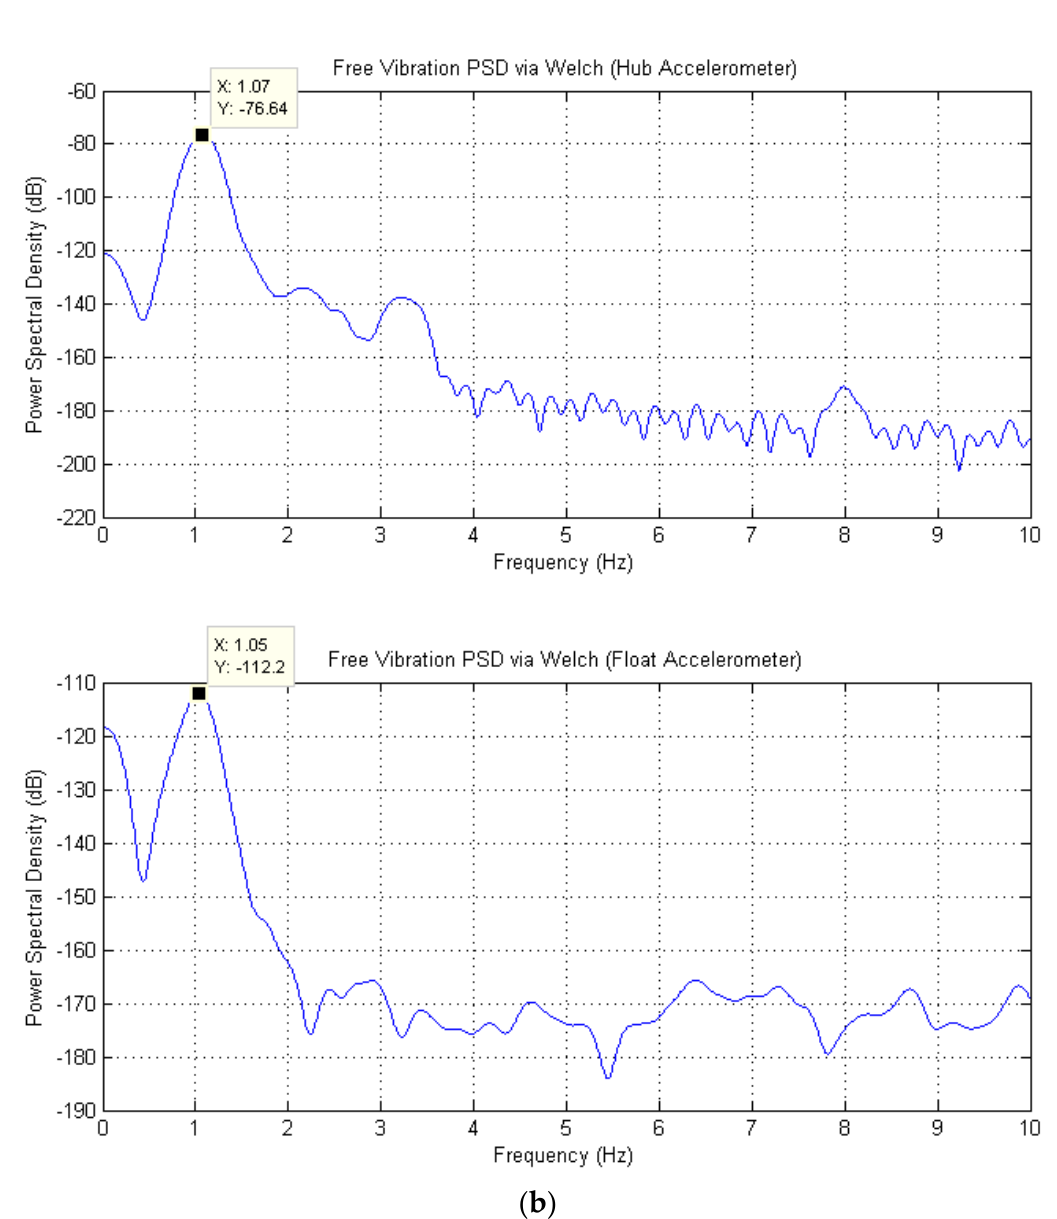
Figure 19. ( a ) Proof of concept of floating wind turbine systems. ( b ) Measurements from the accelerator of the hub and the float.